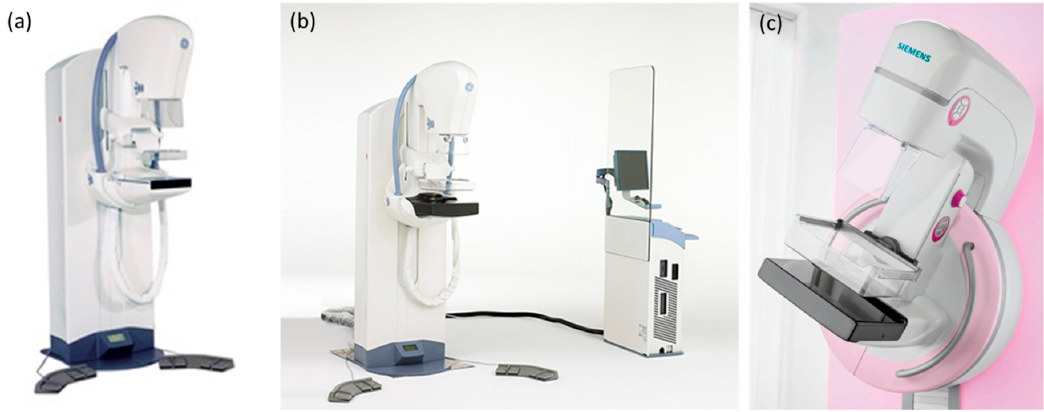
Figure 5. Commercial digital mammography systems employed for dual energy techniques in clinical practice studies: ( a ) Senographe DS, ( b ) Senographe Essential, and ( c ) Mammomat Inspiration [99–102].